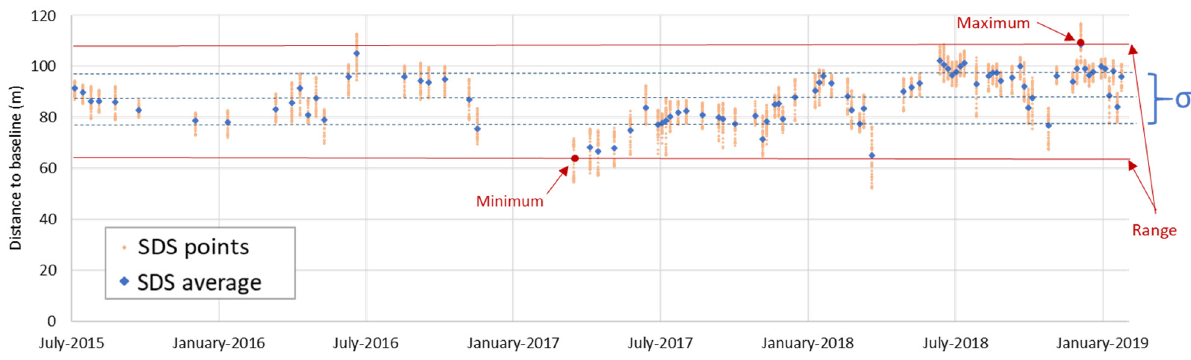
Figure 6. This figure represents, at one sampling location (see Figure 3, C section), the distances between the baseline and the points that compose each SDS (points in light orange, considering a 100 m buffer), as well as their average blue point). The proxy standard deviation (9.8 m, dashed line in blue) was derived considering all SDS average distances while the range (45.1 m, solid line in red) was defined as the difference between the furthest SDS (107.7 m) and the closest one (63.7 m).